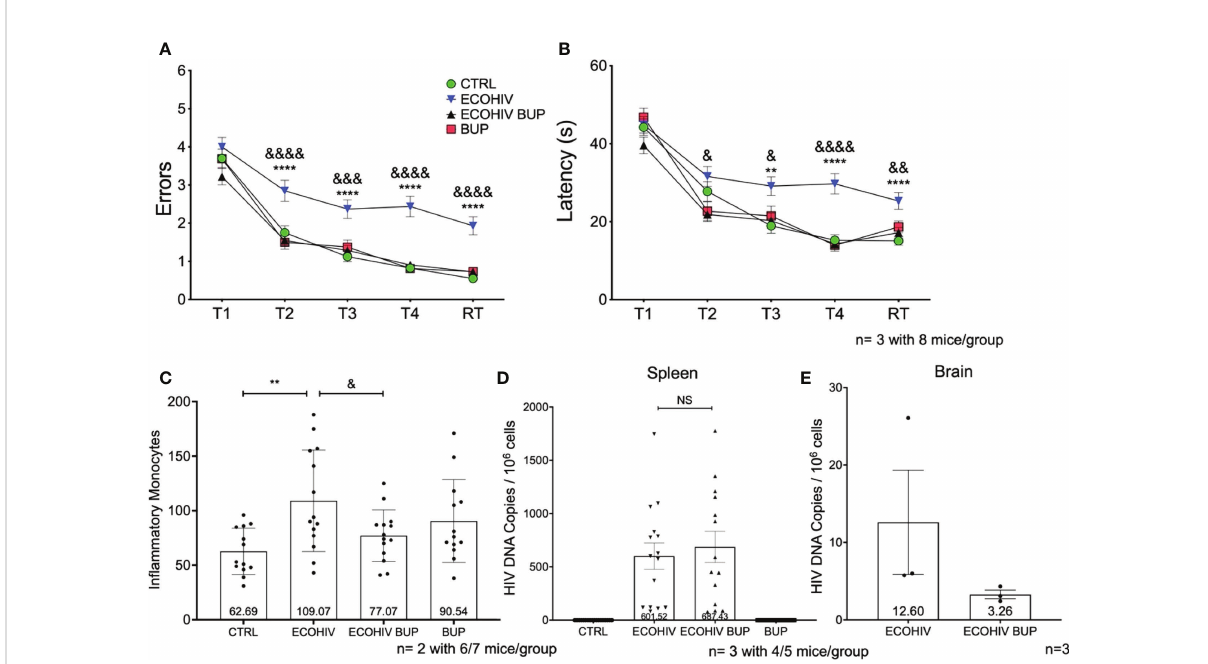
FIGURE 4 Buprenorphine reverses cognitive impairment and reduces brain in fl ammatory monocytes when given four weeks post-EcoHIV infection. C57BL/6J mice in each experimental group; CTRL (green circles), ECOHIV (blue inverted triangles), ECOHIV BUP (black triangles), and BUP (red squares) were tested using a radial arm water maze. Mice were infected for four weeks before buprenorphine injections began. After an additional two weeks, mice were assayed for cognitive performance using the RAWM (A, B) . EcoHIV infected mice were cognitively impaired after four weeks of infection as these mice made signi fi cantly more errors (A) and took signi fi cantly longer (B) to fi nd the hidden platform compared to both CTRL (*) and ECOHIV BUP (&) groups. Data are shown as mean+/- SEM from the last three days of water maze testing. There were a total of three independent experiments, each with eight mice/group for a total of 24 mice in the CTRL, ECOHIV, and ECOHIV BUP groups. Two independent experiments were performed with 8 mice for the BUP group for a total of 16 mice for (A, B) Results were analyzed using a one way ANOVA: ECOHIV vs CTRL, **p<0.005, ****p<0.0001. ECOHIV vs ECOHIV BUP, & p<0.05, && p<0.005, &&& p<0.0005, &&&& p<0.0001. (C) Monocytes were quanti fi ed as described in the previous experiments and shows the number of brain in fl